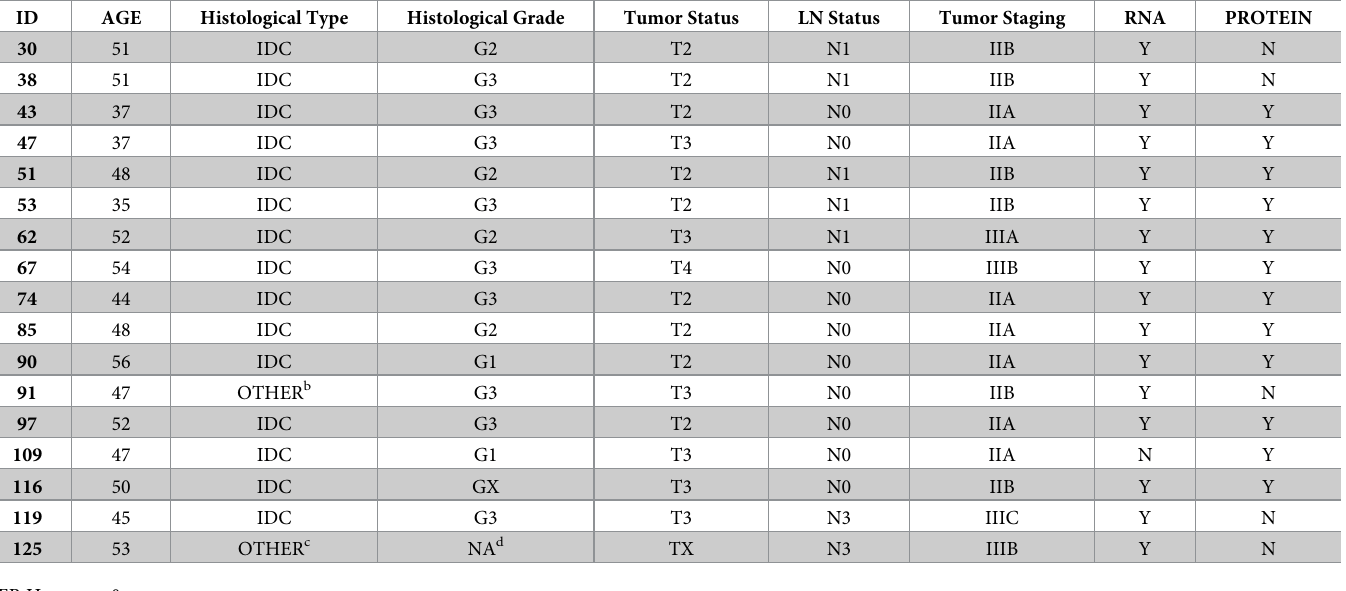
Gene expression profiles corresponding to twenty-five lapatinib-treated and twenty-six trastu- zumab-treated cases were available for analysis (Tables 1–4). We sub-divided the HER2+/ER- Table 1. Lapatinib-treated HER2+/ER- tumors a